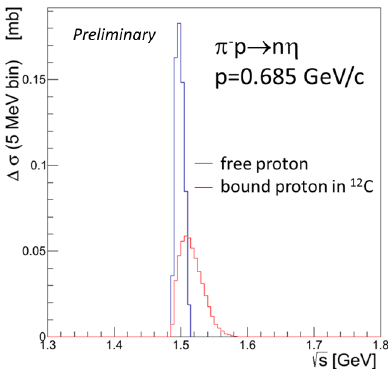
Figure 5. Distribution of cross sections for the π − p → η n reac- √ s (center-of-mass energy) for the tion in 5 MeV wide bins in interaction with a free proton (blue) and a bound proton in the carbon target